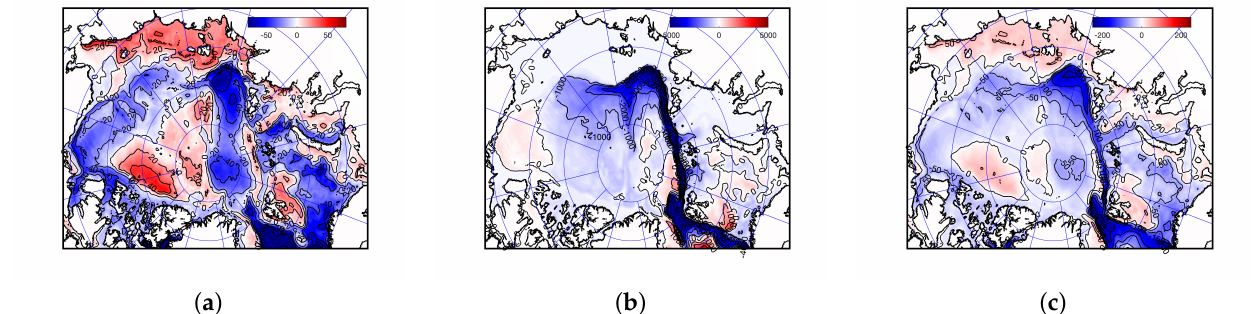
Figure 11. Annually averaged deviations of ( a ) mass of water (kg/m 2 ), ( b ) its heat content (MJ/m 2 ), and ( c ) mass of salt (kg/m 2 ) per square meter of the Arctic area (above 65 N), obtained as a result of vertical integration from the surface to the ocean floor in terms of incremental values in numerical experiment B to experiment A.